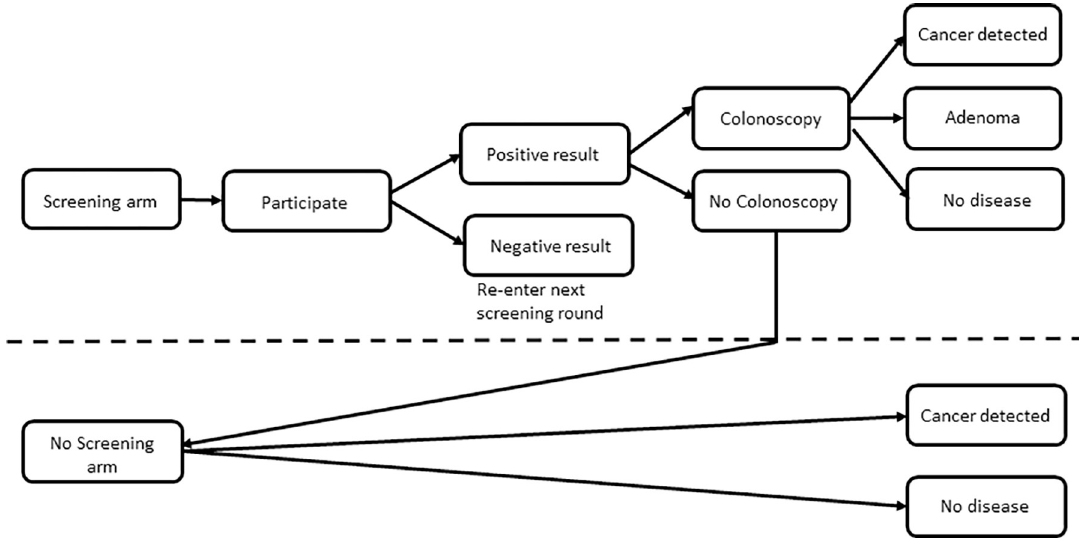
Fig 1. Screening and outcomes